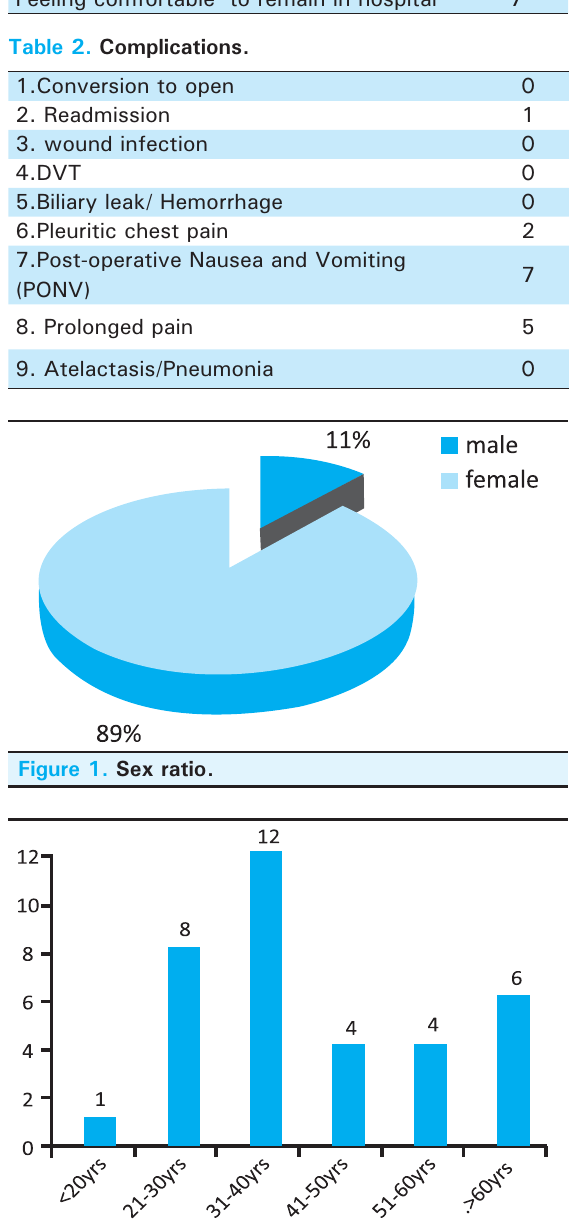
Figure 2. Number of patients according age range.